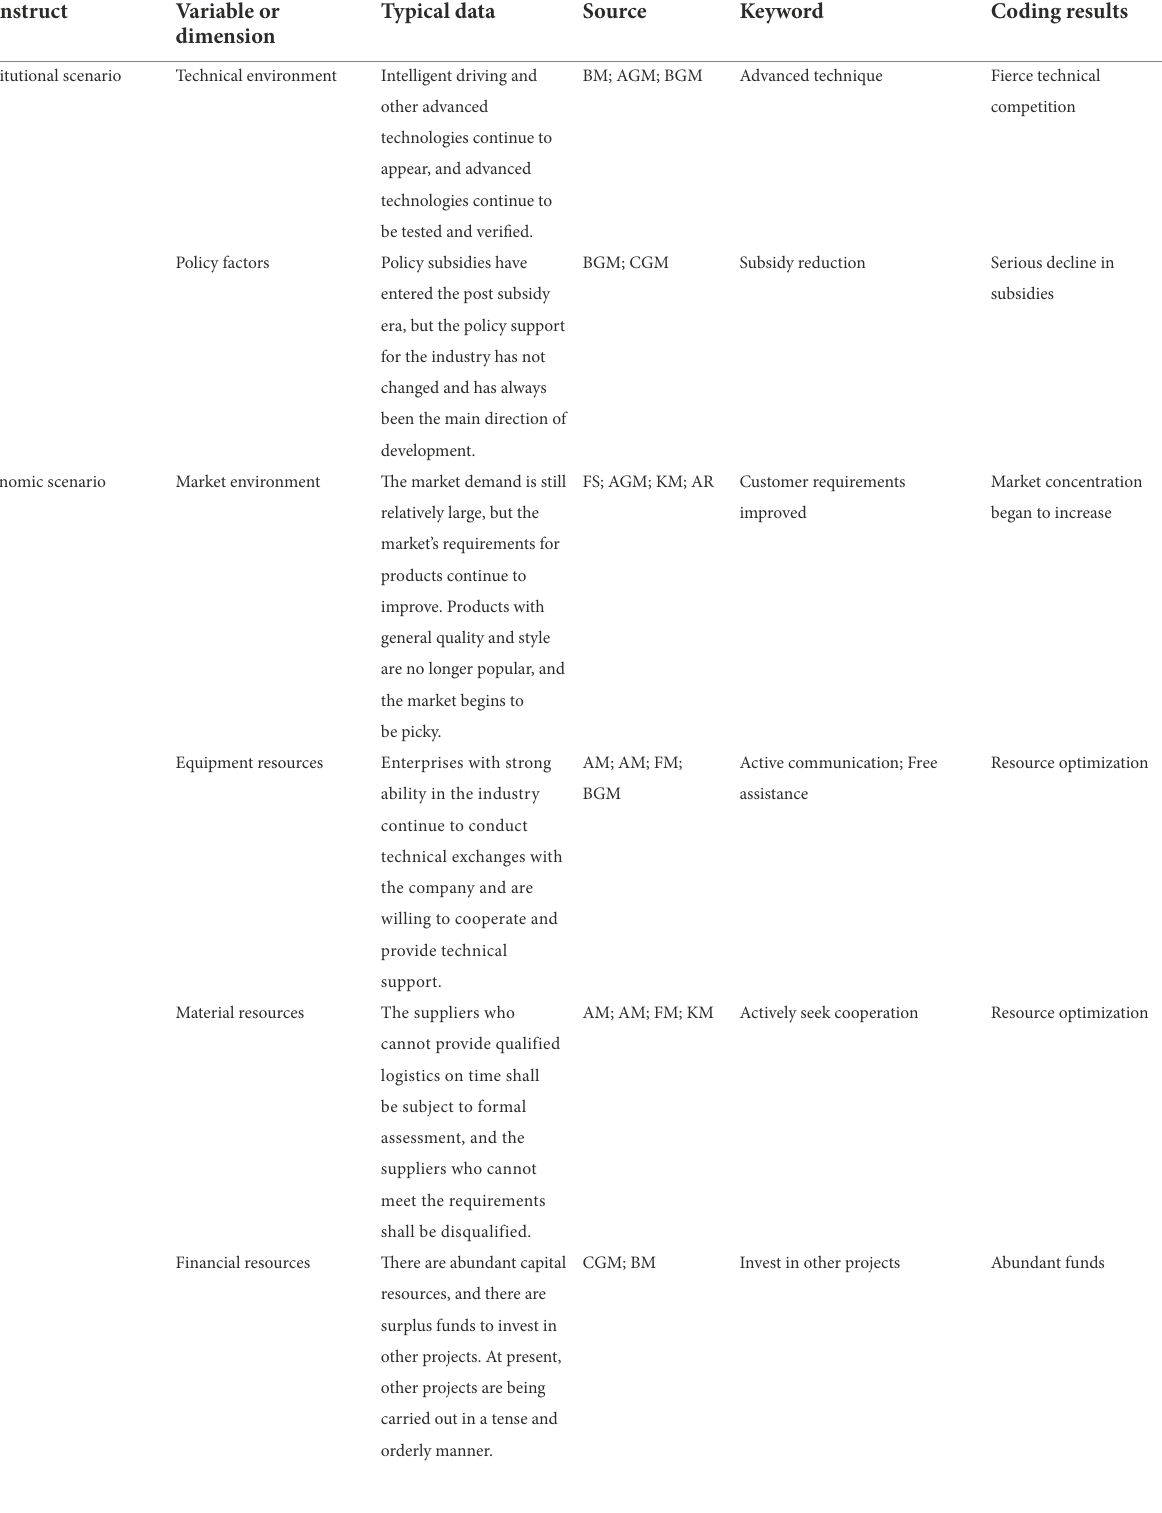
TABLE 8 Citation examples and coding results in phase